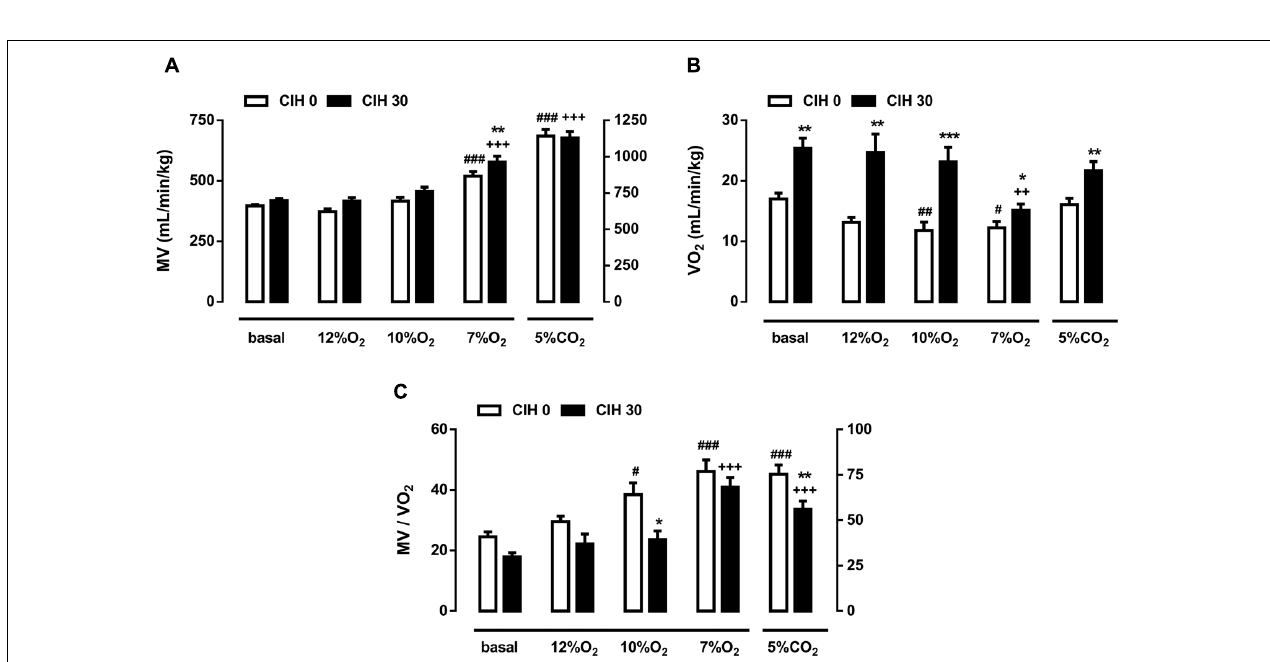
FIGURE 2 | Effect of chronic intermittent hypoxia on guinea pig ventilation. (A) Minute volume (MV; mL/min/Kg) from guinea pigs breathing air, different acute hypoxia (12% O 2 , 10% O 2 , and 7% O 2 ) and hypercapnia (5% CO 2 ) tests. ### p < 0.001 vs. basal CIH0; +++ p < 0.001 vs. basal CIH30; ∗∗ p < 0.01 CIH0 vs. CIH30. (B) Oxygen consumption (VO 2 ; mL/min/kg) of CIH0 and CIH30 guinea pigs in response to the different gas mixtures. # p < 0.05 ## p < 0.01 vs. basal CIH0; ++ p < 0.01 vs. basal CIH30; ∗∗ p < 0.01 ∗∗∗ p < 0.001 CIH0 vs. CIH30. (C) Normalized ventilation to oxygen consumption (MV/VO 2 ) calculated from guinea pigs breathing under the same conditions described above. # p < 0.05; ### p < 0.001 vs. basal CIH0; +++ p < 0.001 vs. basal CIH30; ∗ p < 0.05 ∗∗ p < 0.01 CIH0 vs. CIH30. Data are mean ± SEM; n = 16. Two-way ANOVA with Tukey’s multiple comparison test for analysis between CIH0 and CIH30 groups, and one-way ANOVA with Dunnett’s multiple comparison test for analysis intra group (vs.